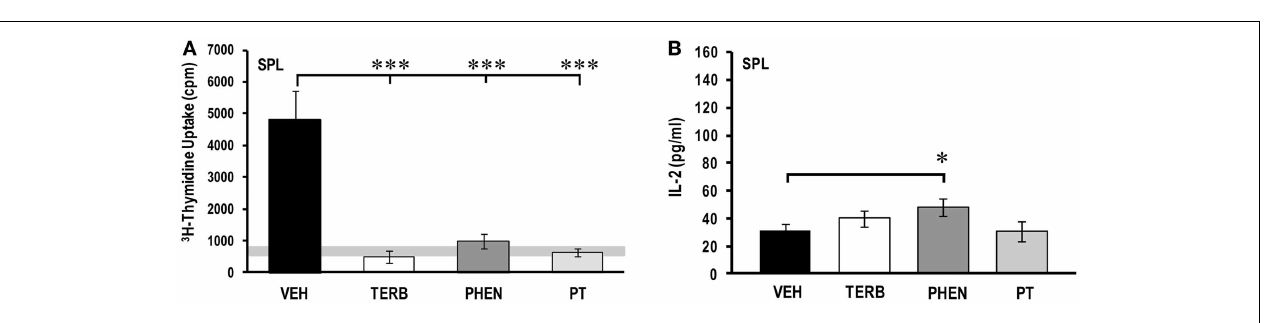
all drug-treated groups compared withVEH controls.The horizontal light gray bar represents the range of non-specific background in untreated non-arthritic rats. N = 8. *** p < 0.001. (B) IL-2 secreted by spleen cells was greater with PHEN compared withVEH treatment, but IL-2 concentrations in the other treatments did not differ fromVEH-treated rats. N = 8. * p <